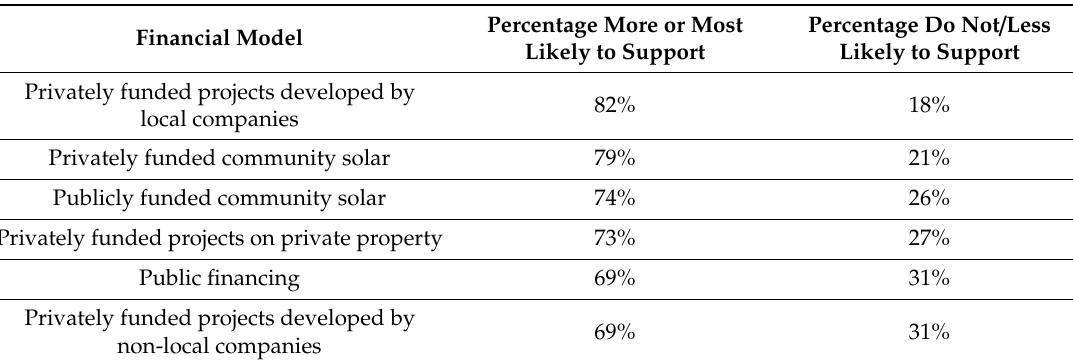
Table 1. Reported Support for Financial Models.